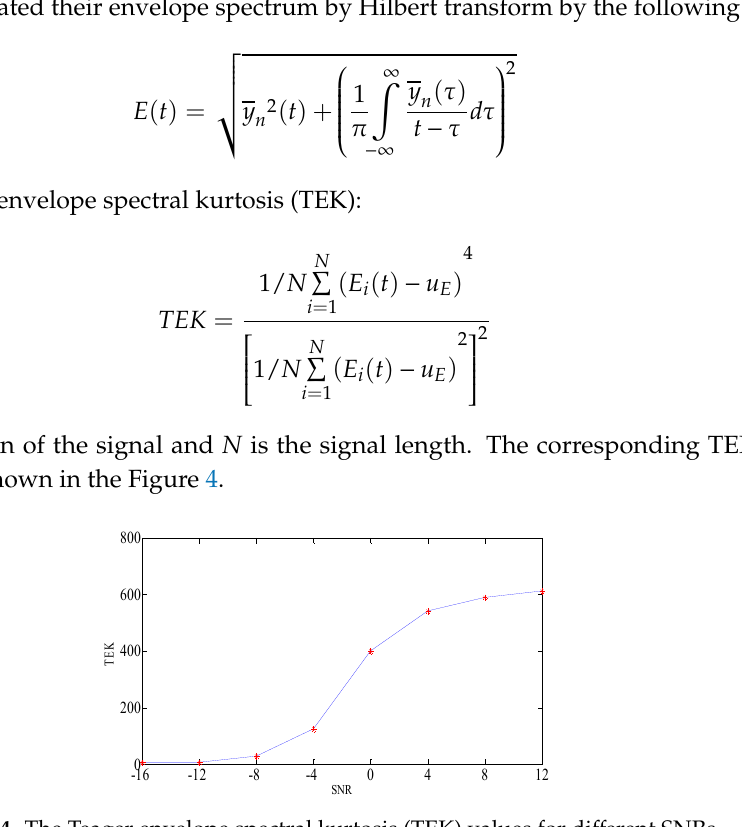
Figure 4. The Teager envelope spectral kurtosis (TEK) values for different SNRs.